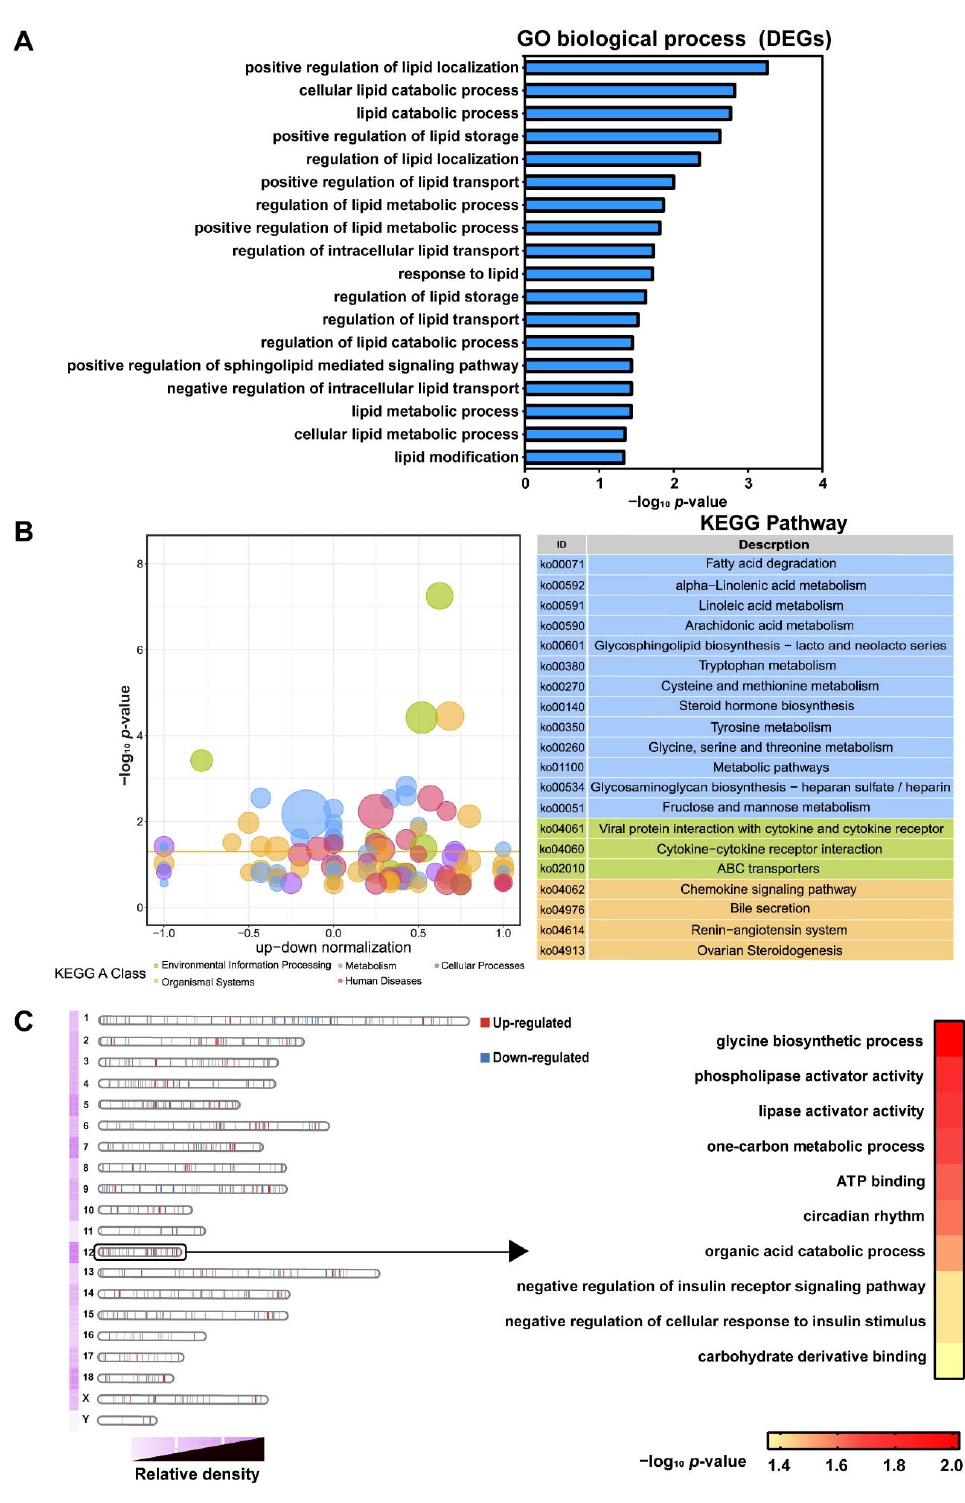
Figure 3. GO and KEGG analysis of DEGs for Duroc and Luchuan adipose. ( A ) GO analysis of DEGs. ( B ) KEGG summary graph showing the summary of the KEGG pathway. Different colors represent different KEGG A class categories. ( C ) Left: distribution of DEGs across chromosomes. Right: significantly enriched GO terms by DEGs in chromosome 12.